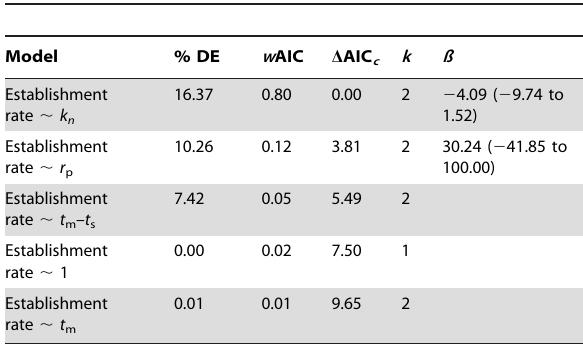
Table 3. General linear model comparisons of relationships between genetic predictors and establishment rate (%) of Eucalyptus gracilis progeny